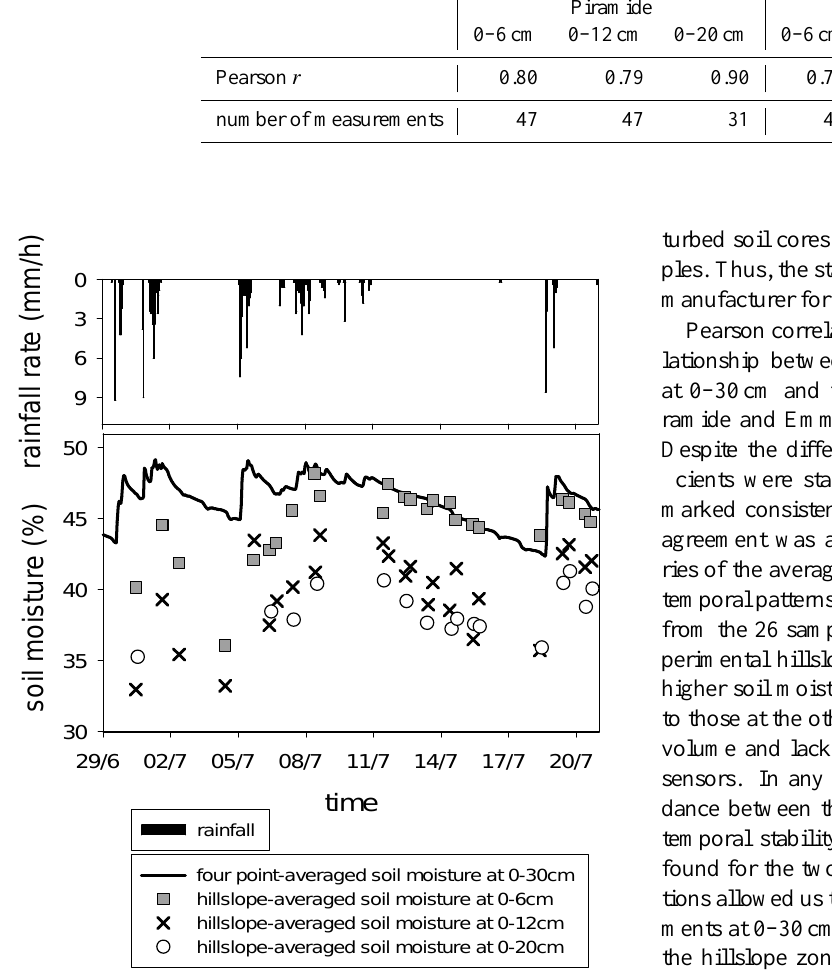
Figure 2. Time series of four point-averaged soil moisture at 0-30 cm (uncalibrated) and hillslope-averaged soil moisture at 0-6, 0-12 and 0-20 cm 653 Fig. 2. Time series of four point-averaged soil moisture at 0–30cm depth (calibrated) for Emme during the 2005 field campaign. 654 (uncalibrated) and hillslope-averaged soil moisture at 0–6, 0–12 and 0–20cm depth (calibrated) for Emme during the 2005 field